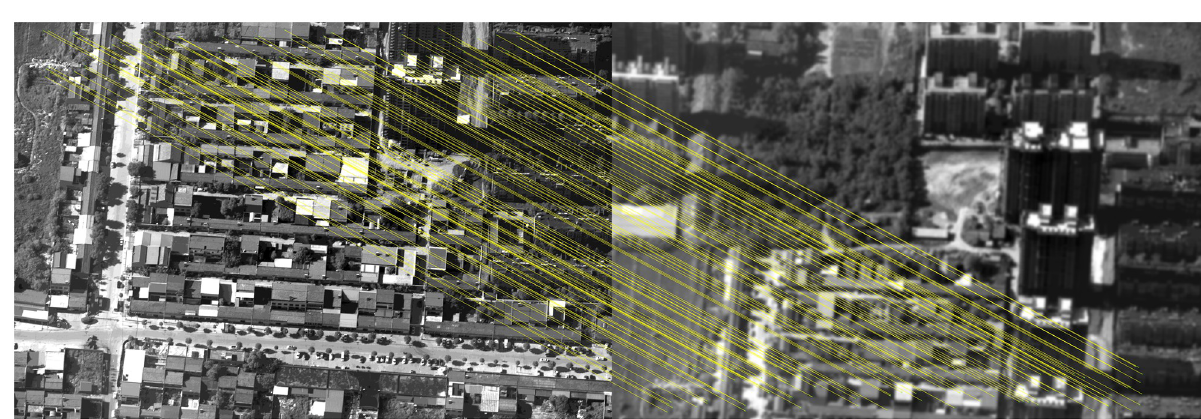
Fig 20. Matching results of this algorithm for aerial images with different sharpness when the swinging angle is large.